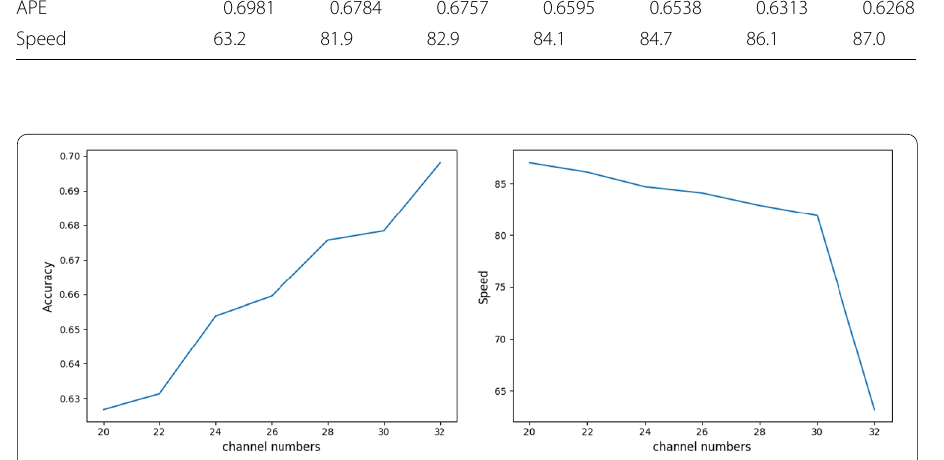
Fig. 11 Accuracy and speed on the OTB2013 datasets with different